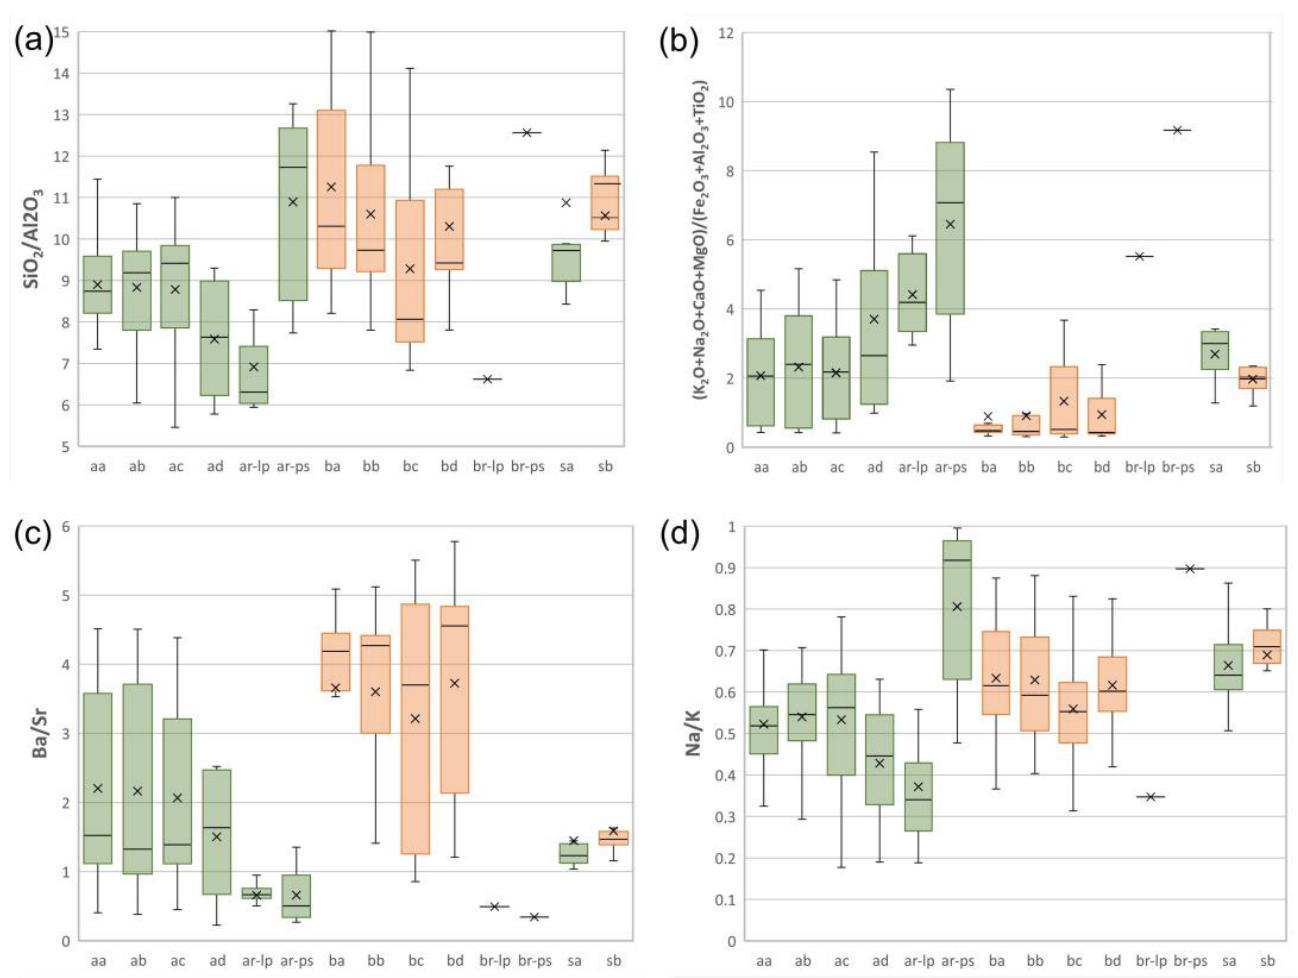
Figure 8. Distribution of weathering indices ( a ) SiO 2 /Al 2 O 3 ; ( b ) (K 2 O + Na 2 O + CaO + MgO)/(Fe 2 O 3